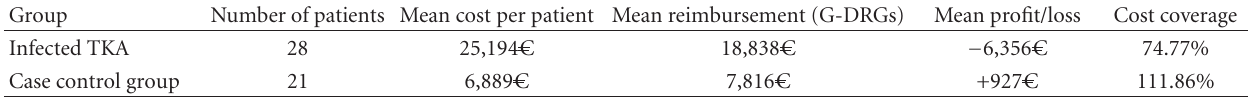
Table 3: Cost analysis of infected TKA and the case control group with reimbursements from the G-DRGs in Euro (C).